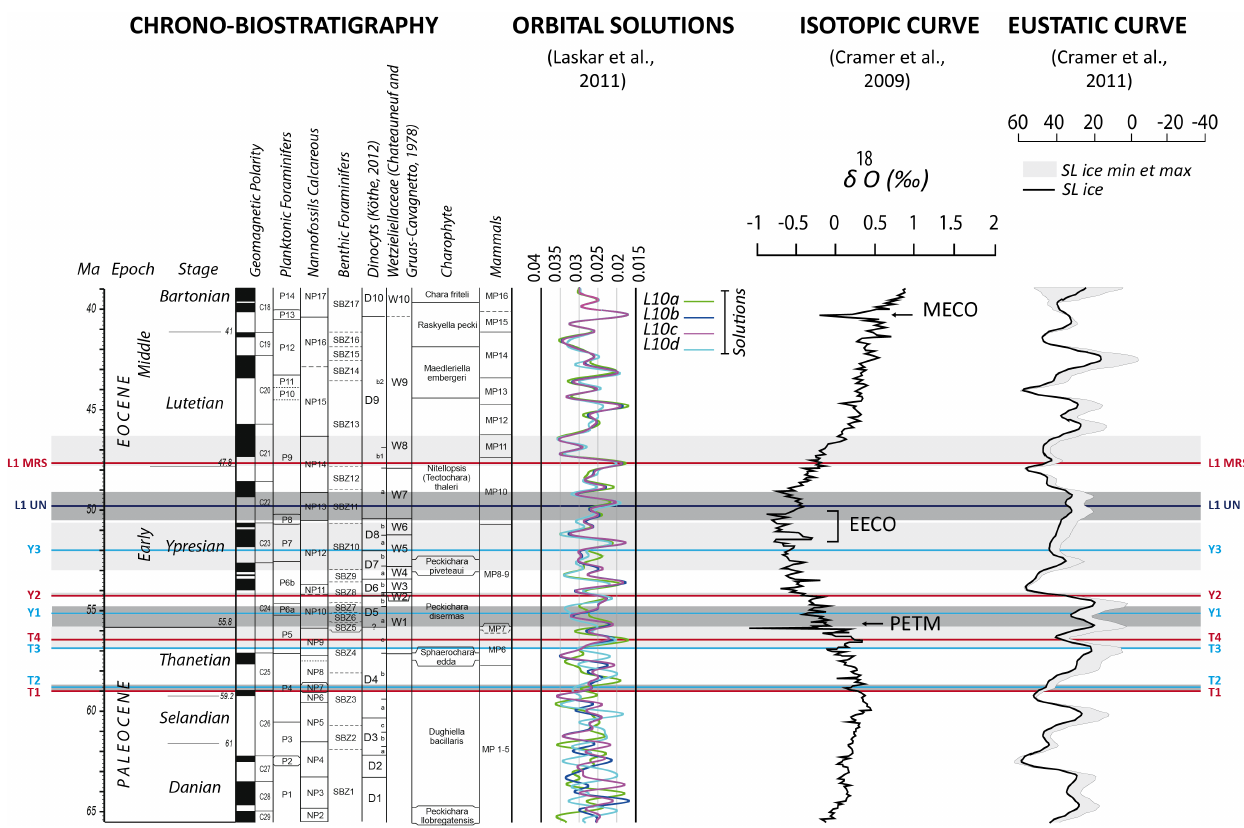
Figure 3. Age model for the Palaeocene–Lower Eocene of the Paris Basin based on re-evaluated biostratigraphic data (this study) calibrated on recent bio-chronostratigraphic charts (Gradstein et al., 2012; Köthe, 2012; Châteauneuf and Gruas-Cavagnetto, 1978; revised in this study) and on the calibration of sequences on both the orbital solutions (Laskar et al., 2011) and isotopic curve (Cramer et al., 2009); see text for discussion and Table